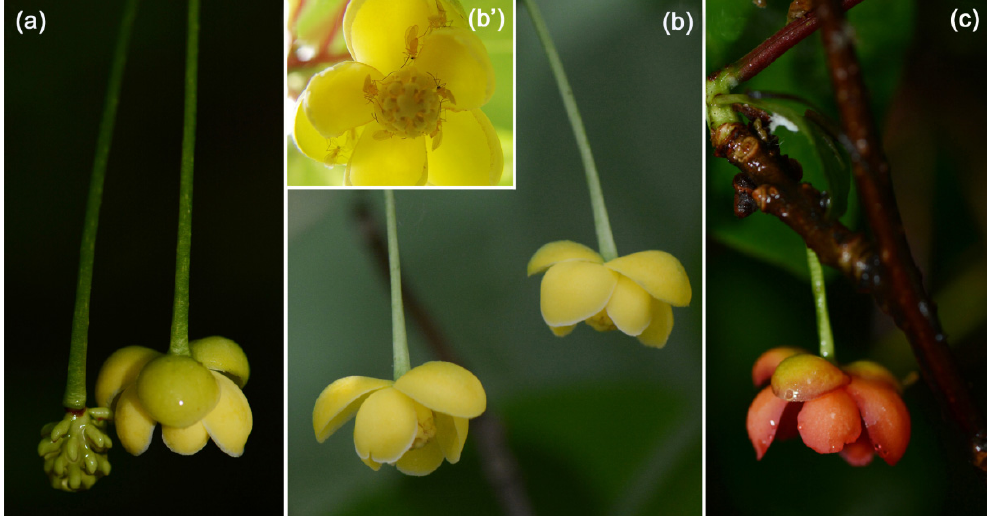
Figure 2. Phenotypes of Schisandra sphenanthera flowers: ( a ) yellow female flower; ( b ) yellow male flower and Resseliella pollinators ( b’ ); ( c ) red male flower.